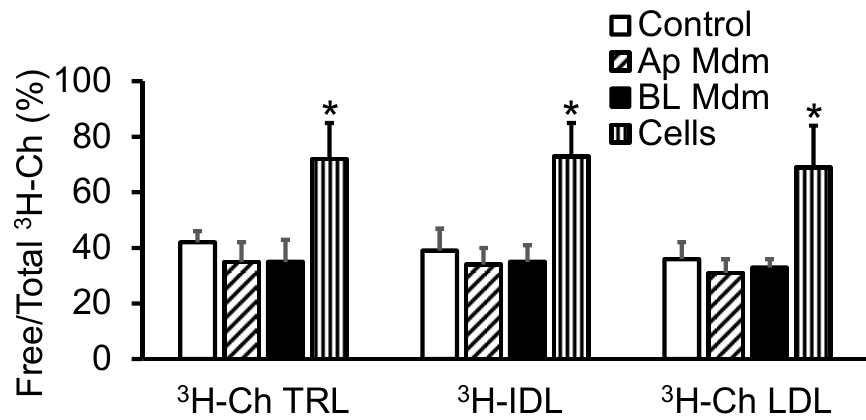
Figure 2. The free/total cholesterol ratio of transported apoB-LPs remains unchanged. The AP side of the MAEC monolayer was incubated with 20 µ g/mL (35,000 DPM) of 3 H-Ch-labeld TRLs, IDLs, or LDLs for 24 h. The free 3 H-Ch and esterified 3 H-Ch in the AP and BL media and cell lysates, as well as in the cell-untreated TRLs, IDLs, and LDLs (control), were separated by digitonin precipitation and assessed by scintillation counting. The percentage of free to total 3 H-Ch was calculated as follows: (free 3 H-Ch/(esterified 3 H-Ch + free 3 H-Ch)) × 100. Values represent the mean ± SE of three experiments; * p < 0.05 vs. control.